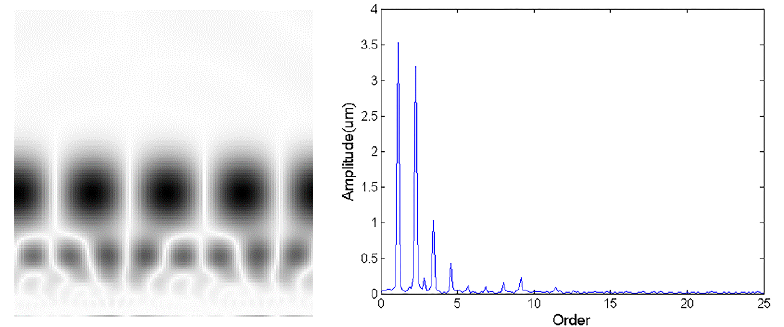
Figure 10. CWTS and spectrum of the imbalance test data.